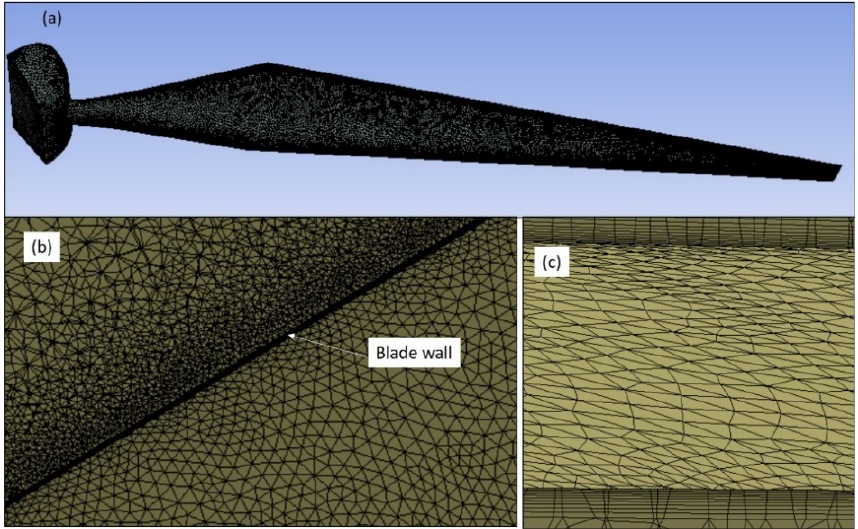
Figure 5. ( a ) Element distribution over the blade, ( b ) element distribution near the blade-fluid in- terface, ( c ) inflation mesh distribution over the blade.